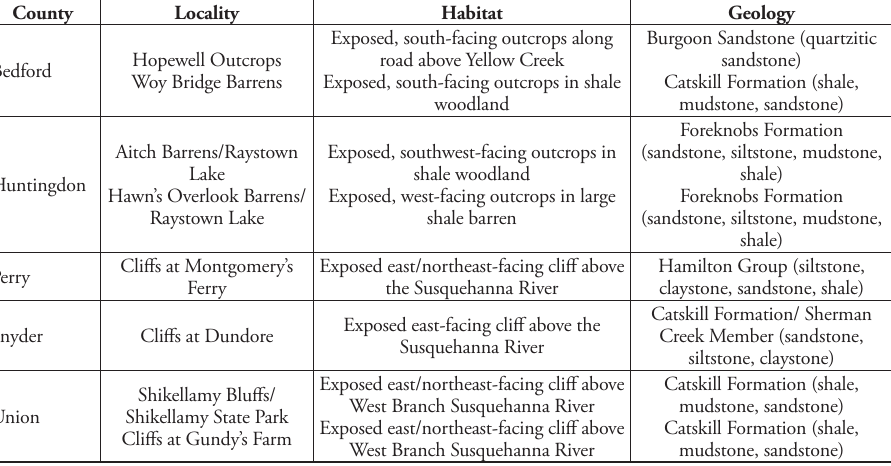
Table 1. Survey locations with general habitat information for Heuchera alba in Pennsylvania.